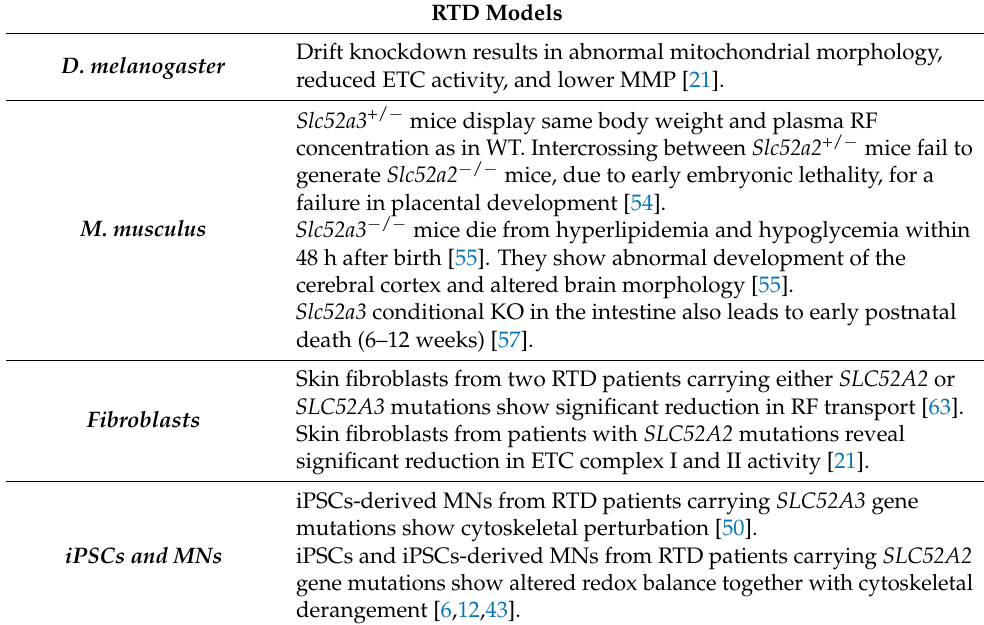
Table 2. RTD in vivo and in vitro